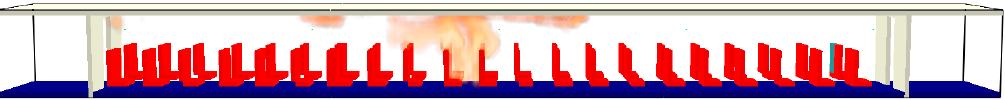
Energies 2020 , 13 , x FOR PEER REVIEW Figure 14. Flame spread within the polyester-type lining after 125 s. Figure 14. Flame spread within the polyester-type lining after 125 s.